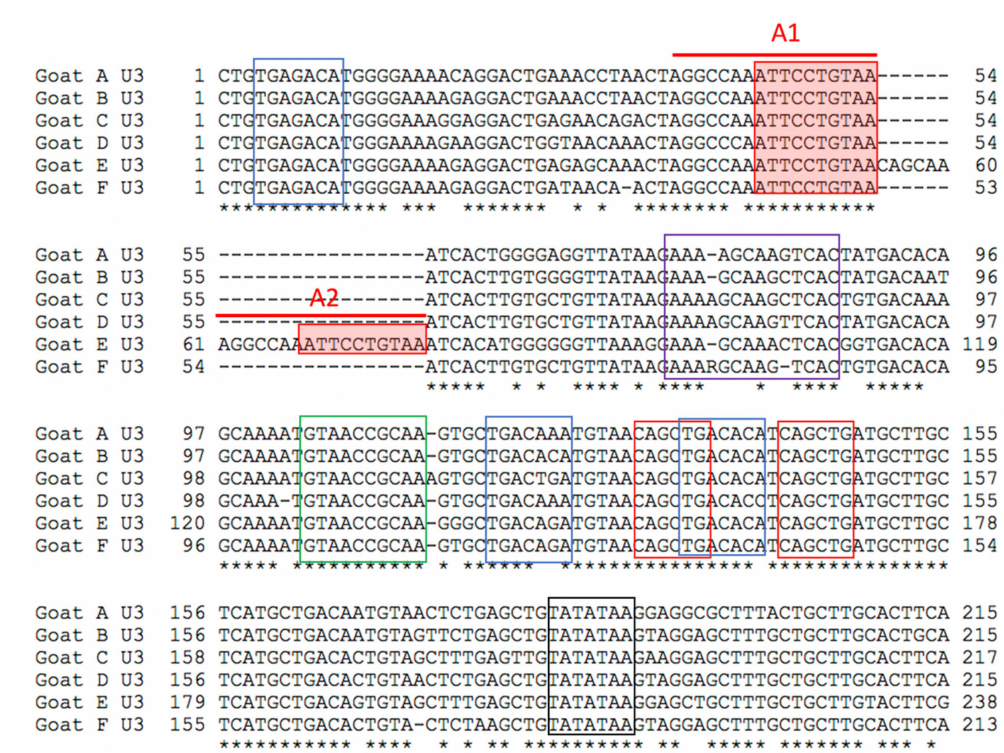
Figure 6. Alignment of the six CAEV U3 sequences derived from renal tissues of goats A, B, C, D, E and F. The two A blocks (A1 and A2, red bars) containing the GAS (filled red boxes) are indicated. Other transcriptional factor binding sites are also indicated—AP-1 (3 blue boxes), TAS (purple box), AML (green box), AP4 (2 red boxes) and TATA (black box). Consensus nucleotide positions are indicated with an asterisk.